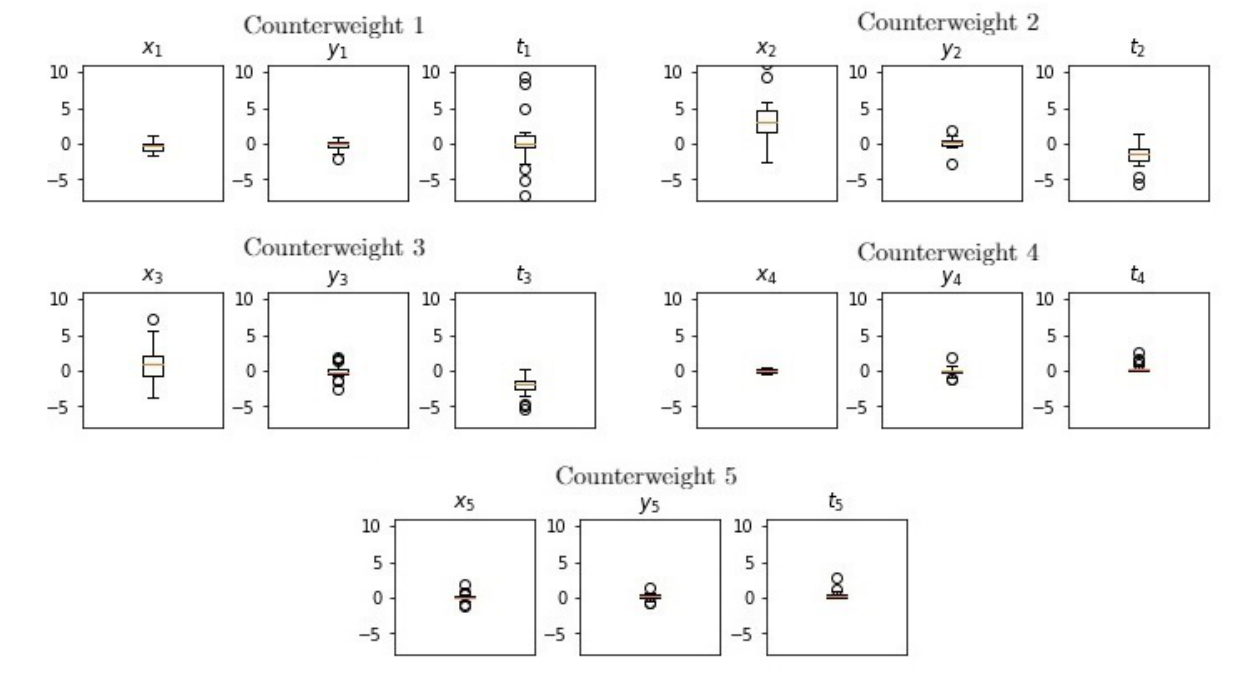
Figure 6. Box plots of partial derivatives of the objective function with respect to each optimization variable when using five